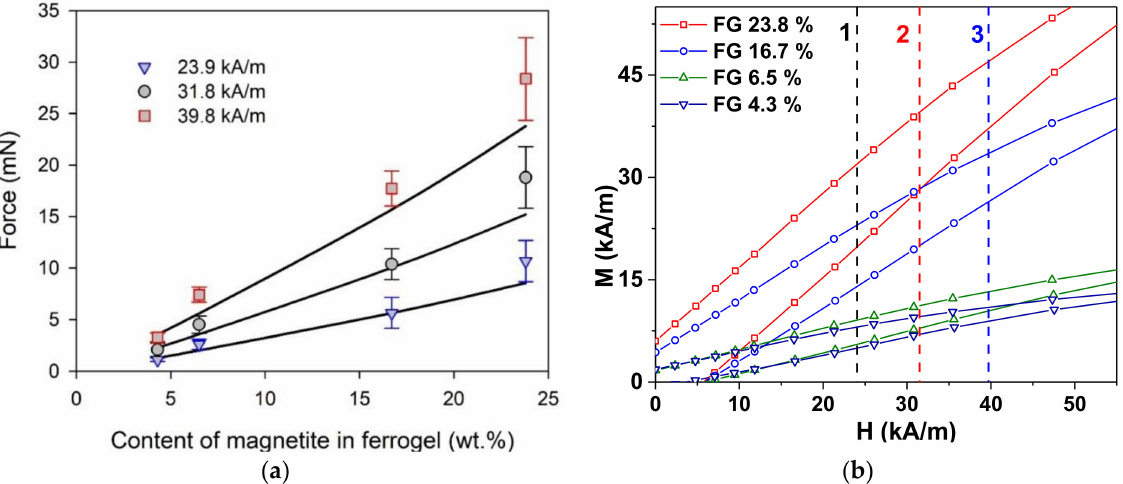
Figure 7. ( a ) Acting force as a function of magnetite weight fraction in ferrogel at selected levels (23.9, 31.8, and 39.8 kA/m) of magnetic field intensity at the surface of the electromagnet. Symbols correspond to the experimental values. Lines give the model evaluation for the dependence according to Equation (6); ( b ) parts of the magnetic hysteresis loops measured by VSM for ferrogel samples with 23.8, 16.7, 6.5, and 4.3 wt.% of magnetic filler. Dashed vertical lines indicate the same fields as used for part ( a ): 1—23.9 kA/m, 2—31.8 kA/m, and 3—39.8 kA/m. It is important to mention that the field strengths at the part ( a ) correspond to the gradient field intensity at the magnet surface. However, the field strengths at the part ( b ) correspond to the uniform external magnetic field used for VSM